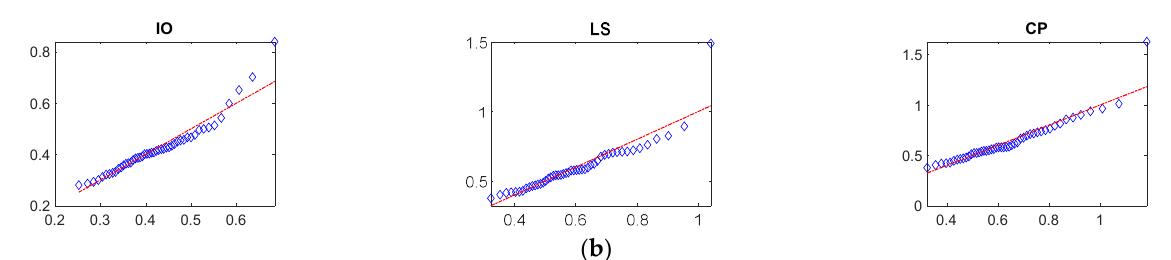
Figure 19. q–q plots of representative IM datasets (all axes are AvgSa in [g]; the horizontal axes are the theoretical quantiles and the vertical axes represent the quantiles of the empirical data): ( a ) datasets representative of cases for which the lognormal distribution hypothesis cannot be rejected—Configuration F8P2G0.0, ( b ) datasets representative of cases for which the lognormal distribution hypothesis is rejected—Configuration F4PS2G1.0.